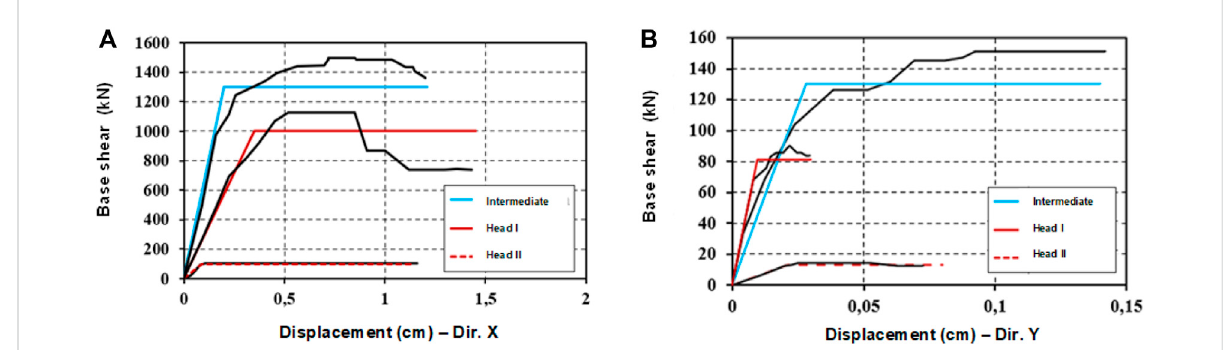
FIGURE 5 Pushover analysis curves in: (A) direction X; (B) direction Y for the SU of the masonry aggregate in Boscoreale.